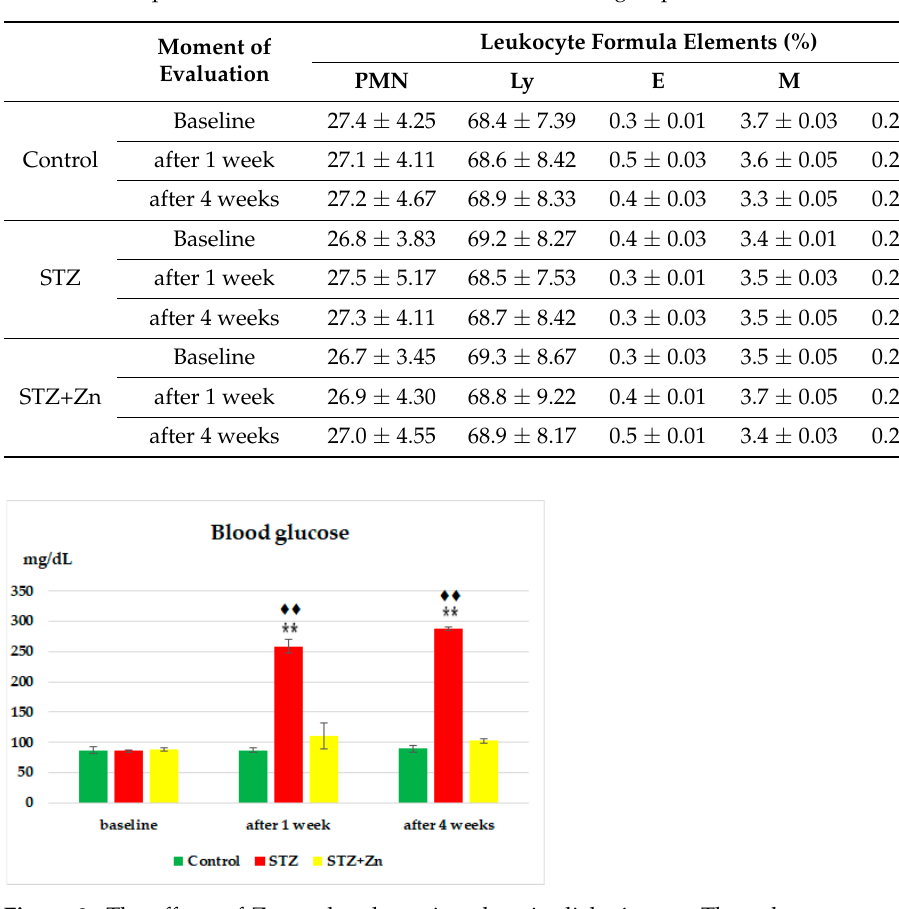
Table 2. The effect of Zn on percentages of the leukocyte formula elements in diabetic rats. (PMN— polymorphonuclear neutrophils, Ly—lymphocytes, M- monocytes, E—eosinophils, B—basophils). The values are presented as mean ± S.D. for five animals in a group.